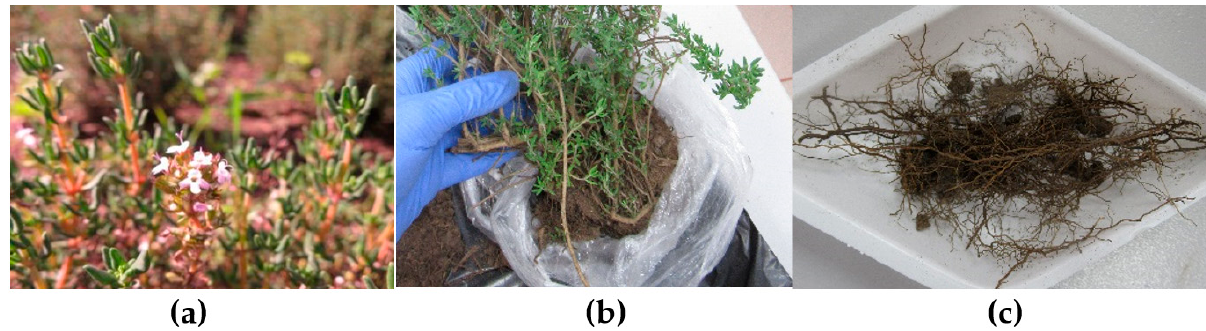
Figure 1. Stages of sampling: ( a ) healthy flowering plants selecting; ( b ) the plant with soil monolith collected; ( c ) rhizosphere with roots.